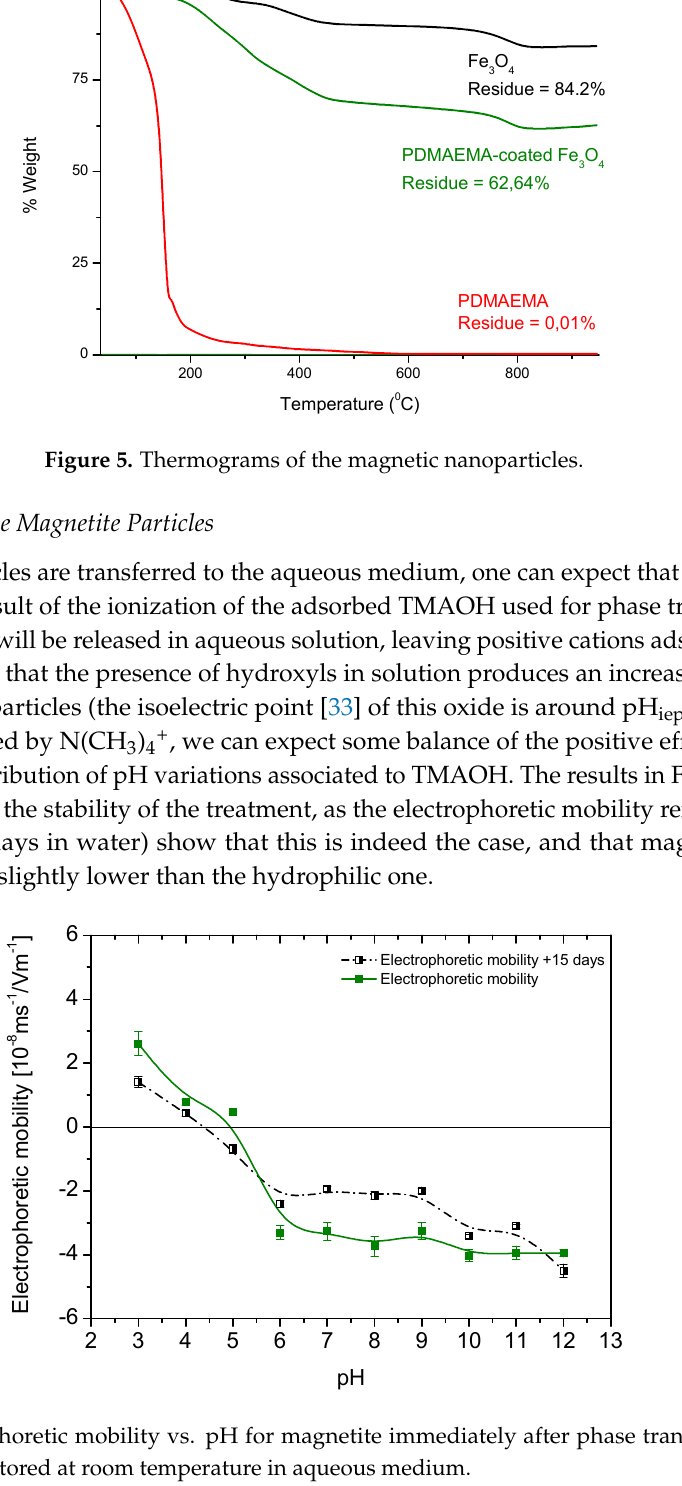
pH Bare Figure 7. Effect of pH on the electrophoretic mobility of magnetite nanoparticles before and after PDMAEMA coating. As mentioned, an essential aspect of the produced nanostructures is their stability. In situ particle size determinations by dynamic light scattering are shown in Figure 8. Rapid flocculation